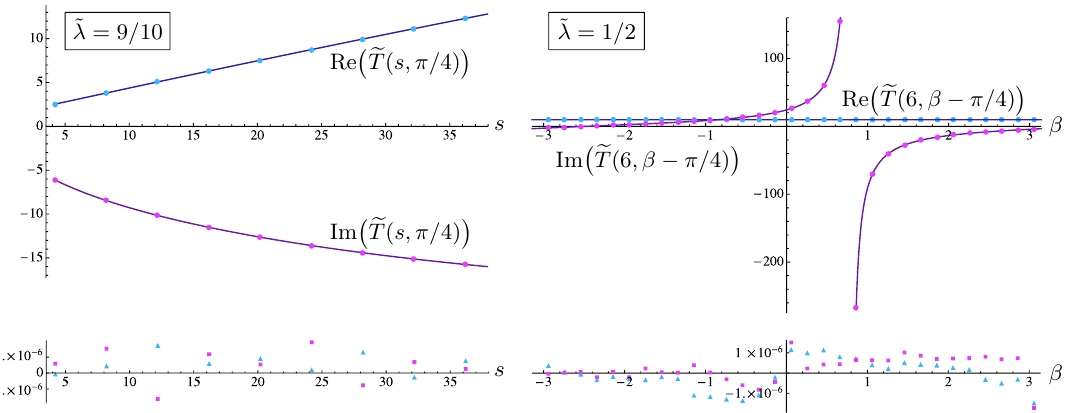
Figure 9 . Additional numerical tests comparing two sides of the integral equation (3.25) with the analytic ansatz. The left panel shows strong coupling data in the same kinematic setup as that of figure 8. The right panel shows data at fixed center-of-mass energy, with s = 6 , and fixed incoming angle α = π/ 4 . The deviation between two sides of the integral equation, for the real and imaginary parts of e T , are shown in the lower